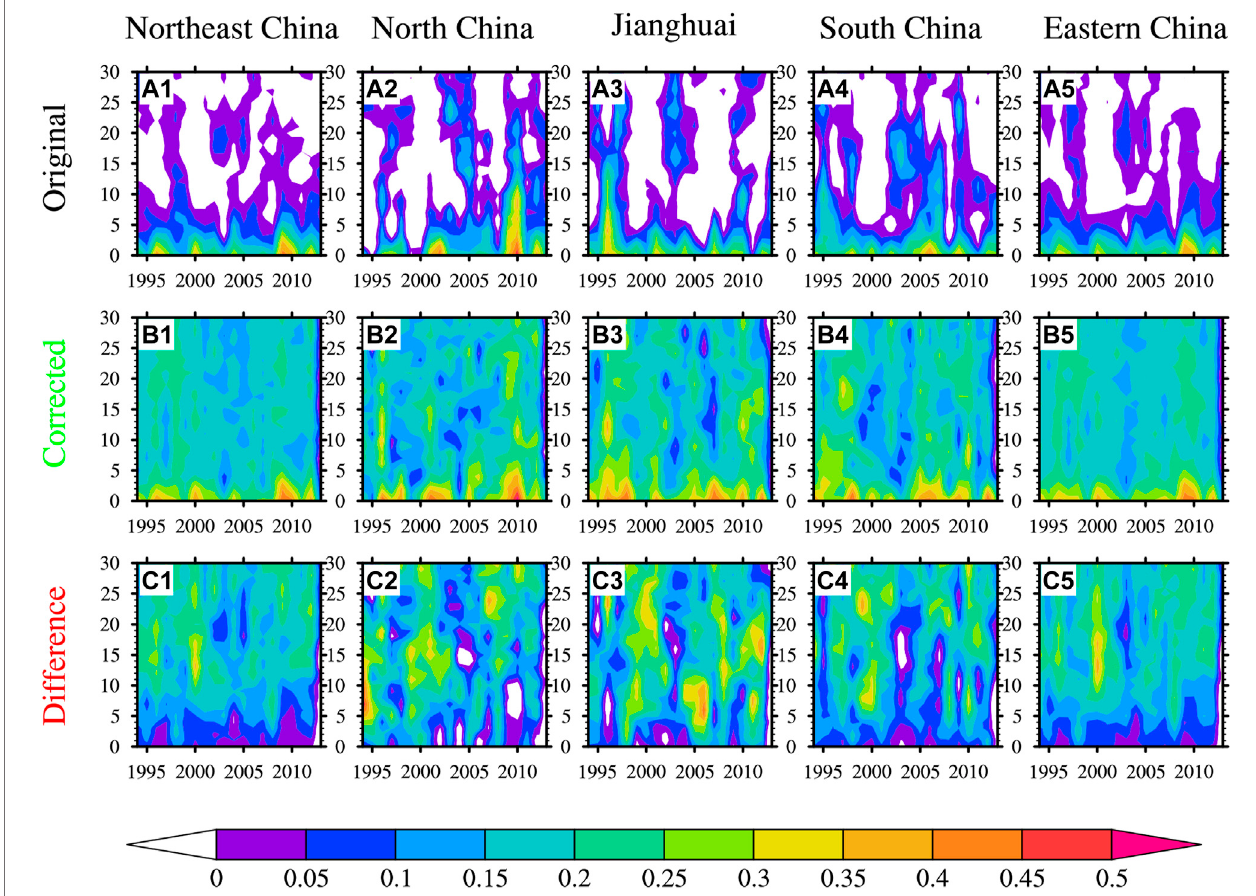
FIGURE 7 | The temporal correlation coef fi cient (TCC) between the original (A1 – A5) , bias corrected predictions (B1 – B5), and observations with the forecast lead time of 0 – 30 days (y-axis) in summer over each region during 1994 – 2013. The differences in TCC between the bias corrected predictions and original predictions for each region are shown in (C1 – C5)